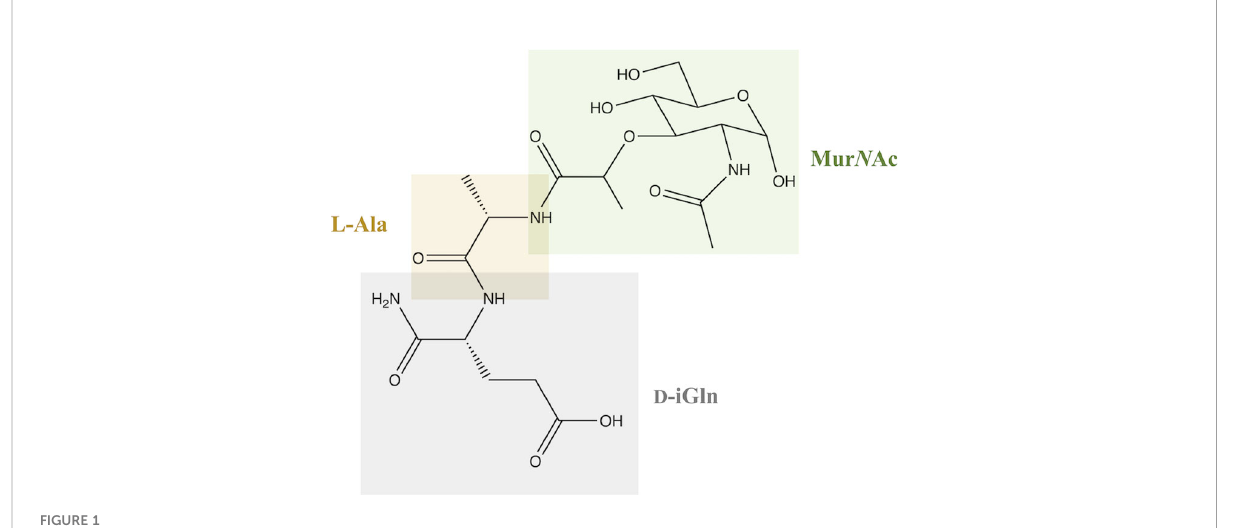
FIGURE 1 Structure of